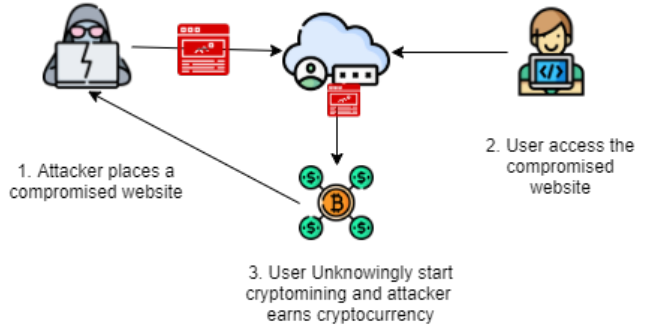
Figure 15. Graphical representation of a crypto-jacking attack